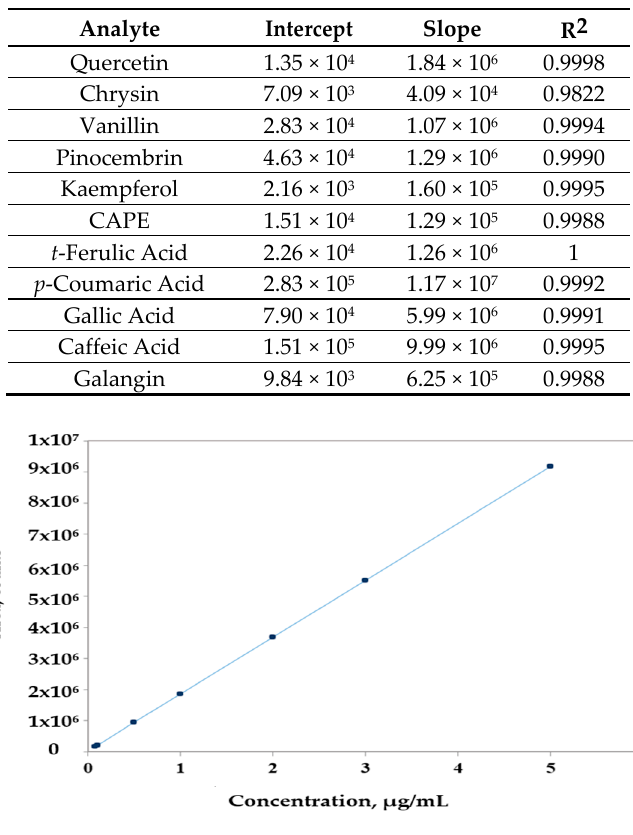
Figure 1. Calibration curve for t -ferulic acid.